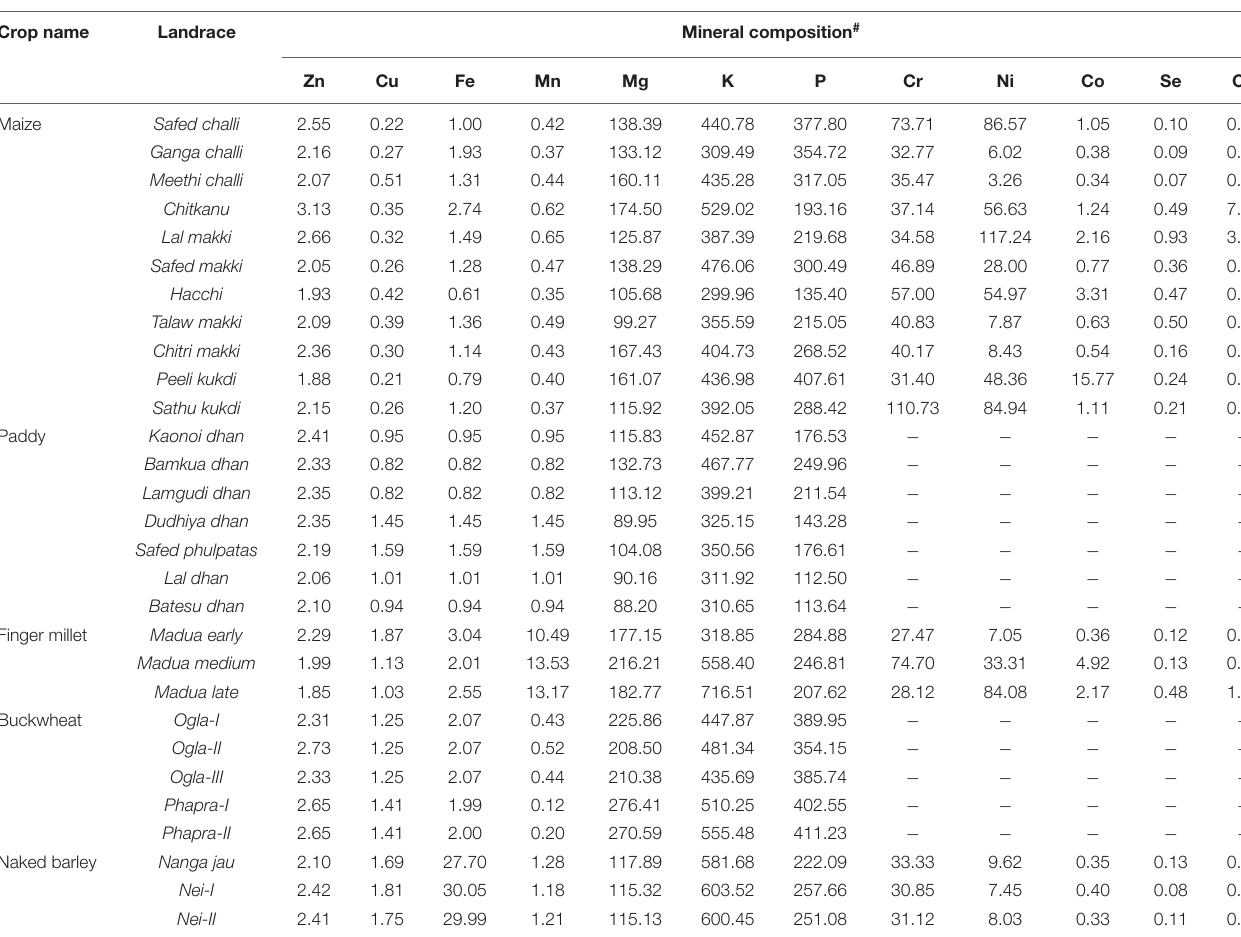
TABLE 3 | Comparison of mineral composition of traditional crop landraces. Crop